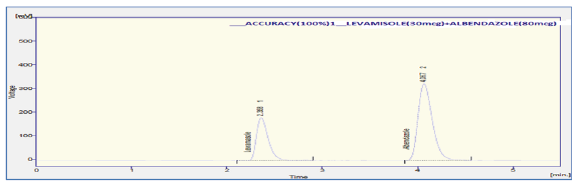
Figure 10: Chromatogram of 100% recovery.